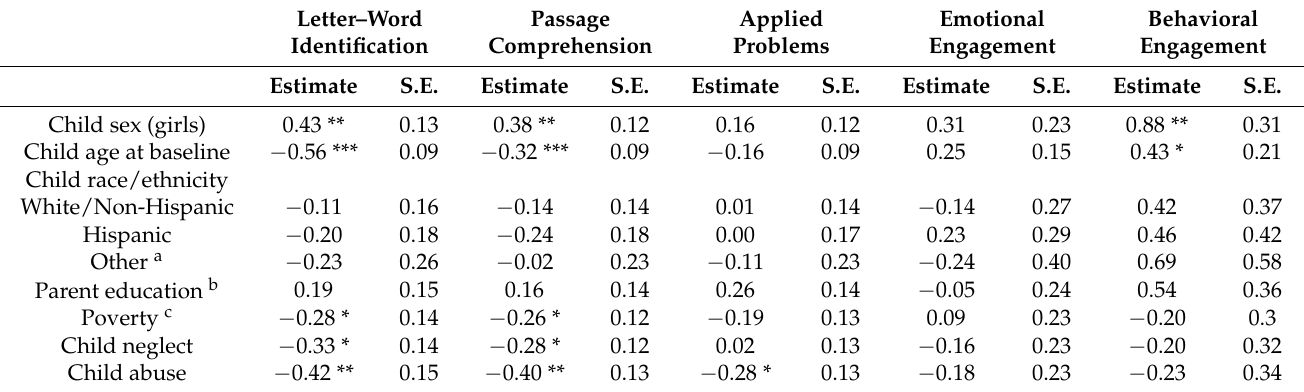
Table 3. The Effects of the Covariates on the Distal